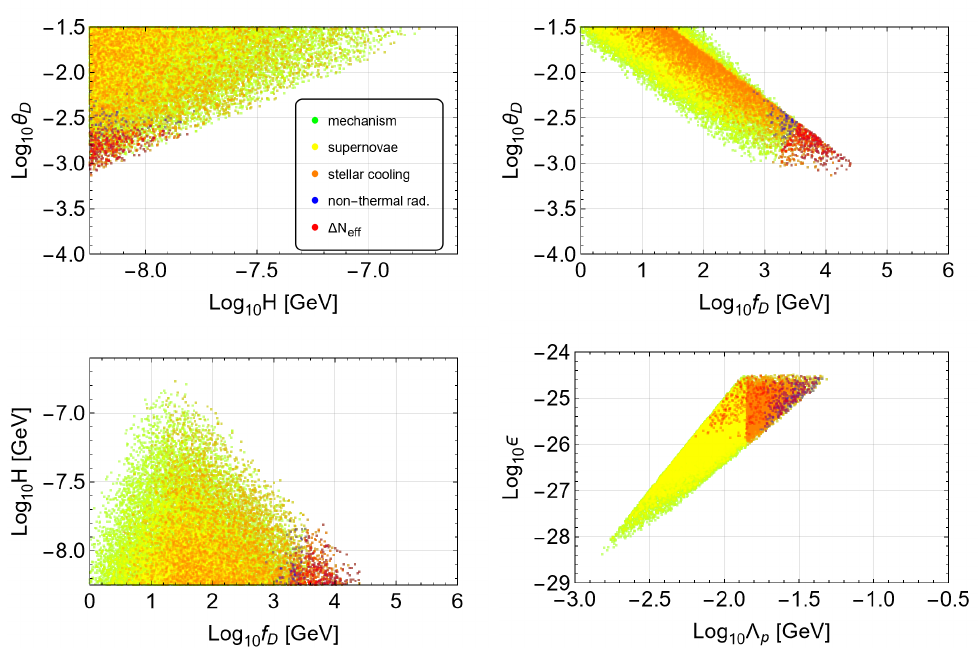
JHEP07(2022)126 Figure 3 . Parameter space scan of points that satisfy the criteria for a successful dark relaxion mechanism (green) and that additionally pass one phenomenological constraint from either super- novae (yellow), stellar cooling (orange), non-thermal dark radiation production from post-reheating rolling (blue), or dark radiation contribution to ∆ N from thermal scattering eff